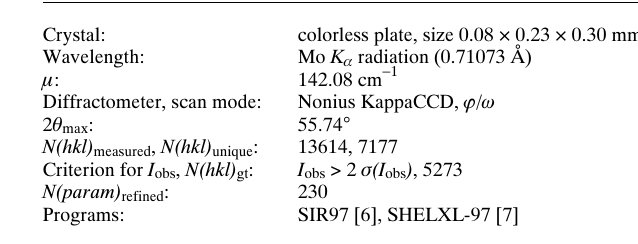
Table 1. Datacollection and handling.